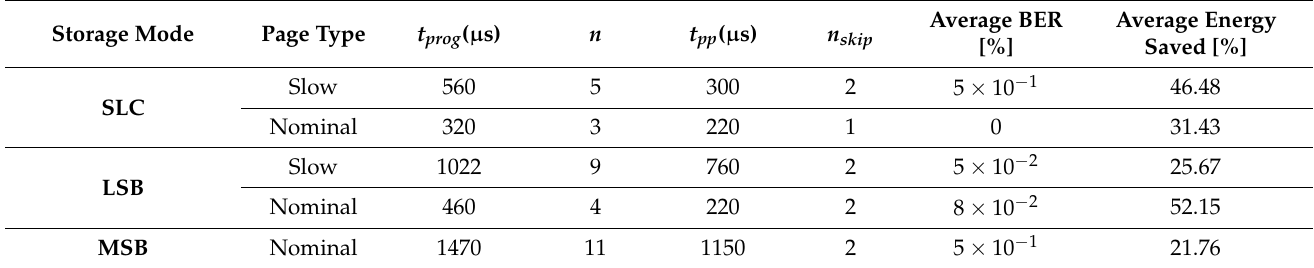
Table 2. EXPRESS characterization for NAND flash block in fresh